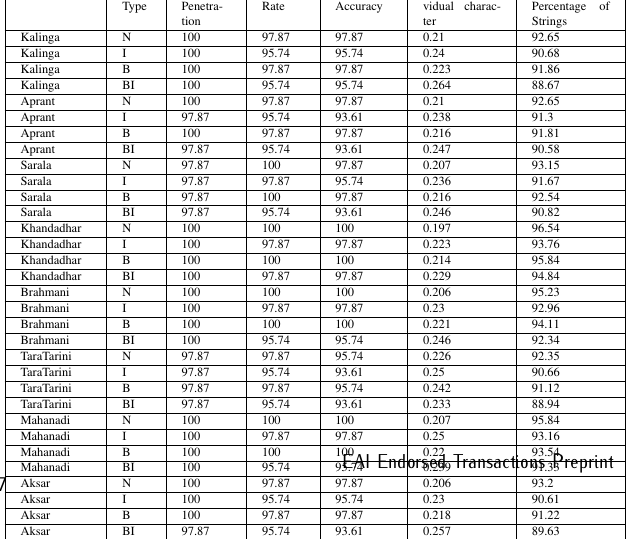
Figure 14. Comparison of computation overhead among various schemes. Table 2. Experimental results for various Odia fonts (N: Normal; I: Italics; B: Bold; BI: Bold Italics). Table 1. Rank-wise rates of classification accuracy.